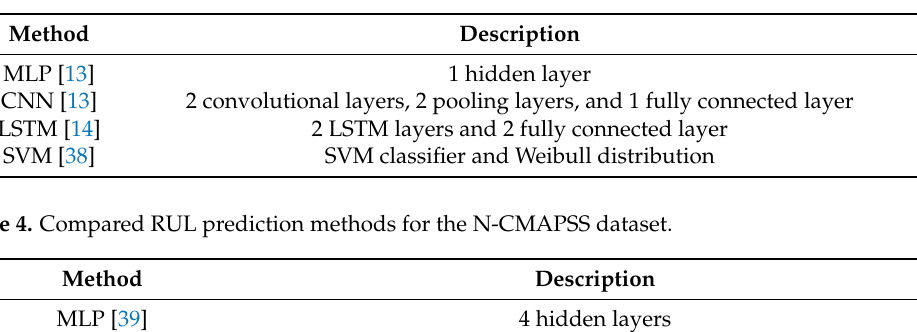
Table 3. Compared RUL prediction methods for the CMAPSS dataset.